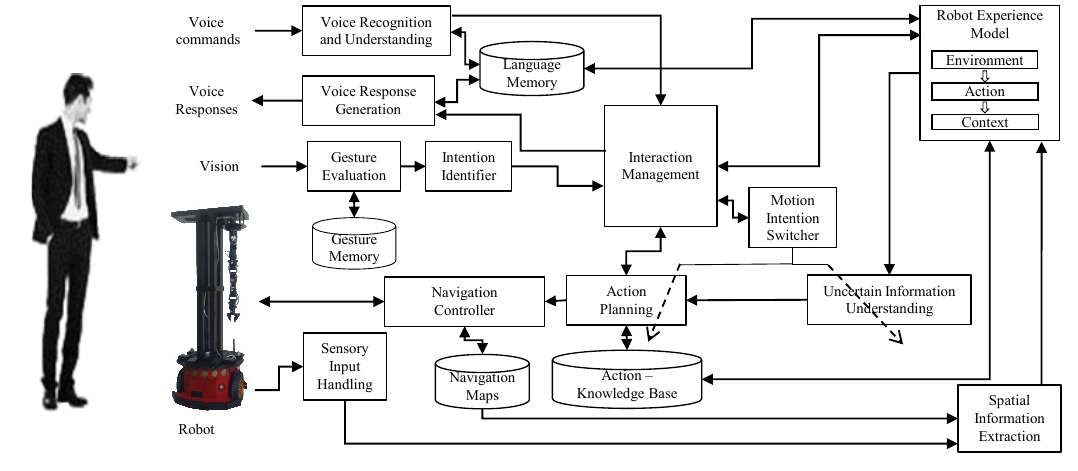
Figure 1. System